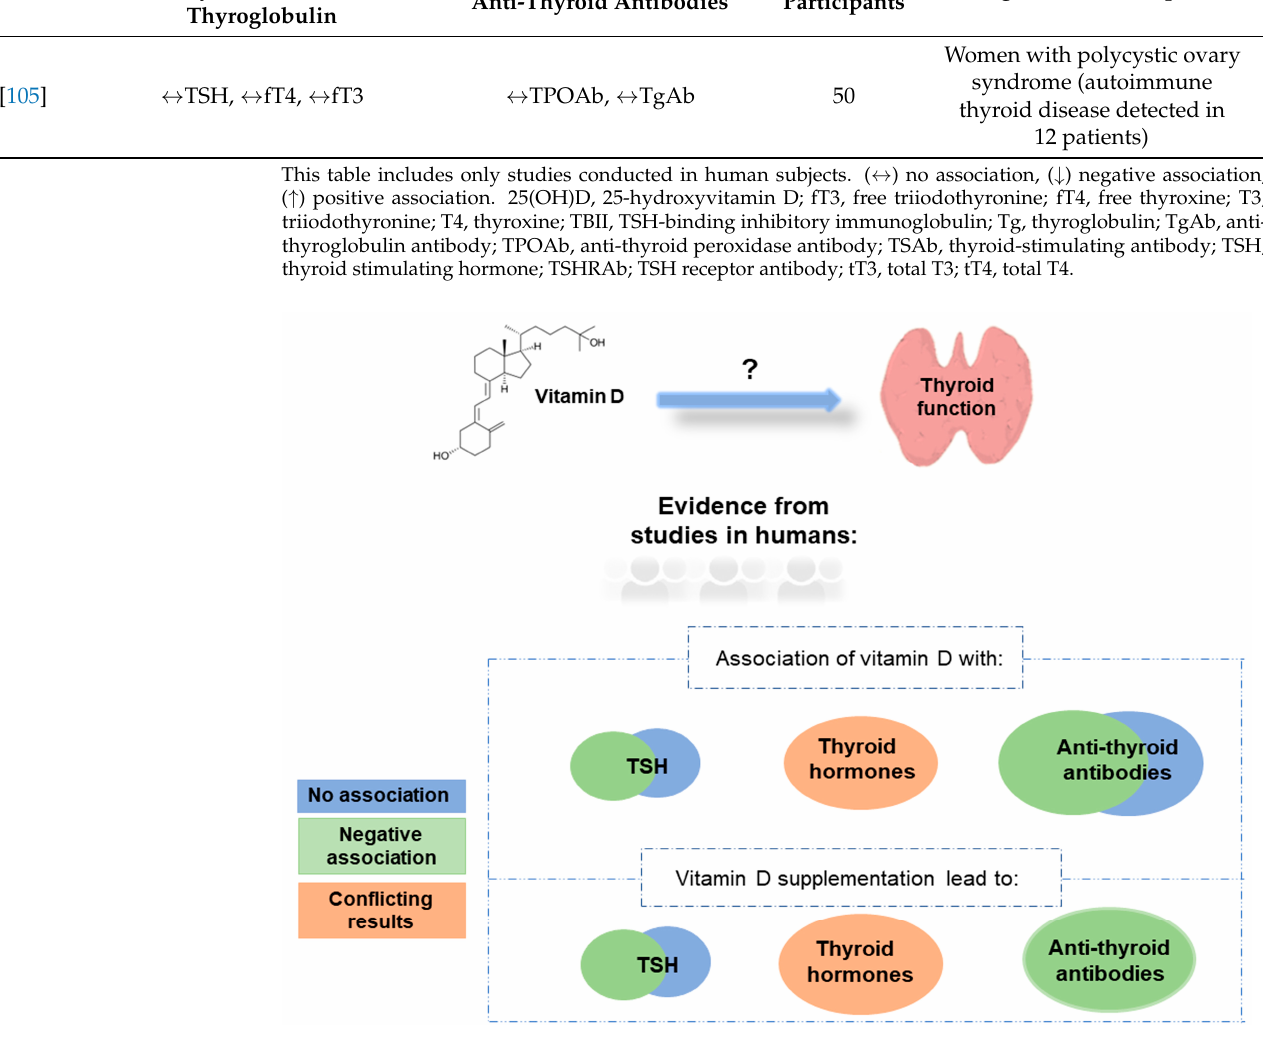
Figure 1. Association of vitamin D with thyroid function (evidence from studies in humans).